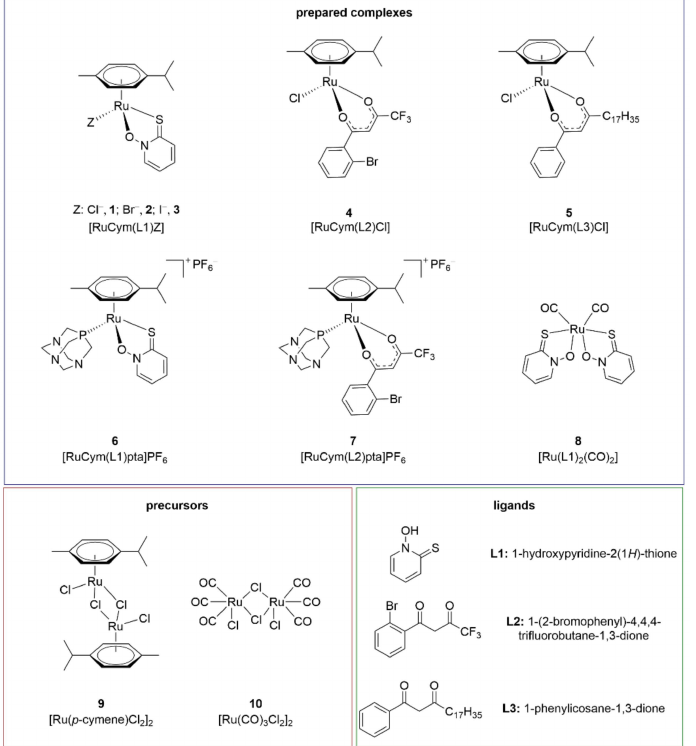
Figure 2. Structures of the investigated complexes ( 1 – 8 ), precursors ( 9 – 10 ) and ligands ( L1 – L3 ). The syntheses of complexes 1 and 6 were previously reported in